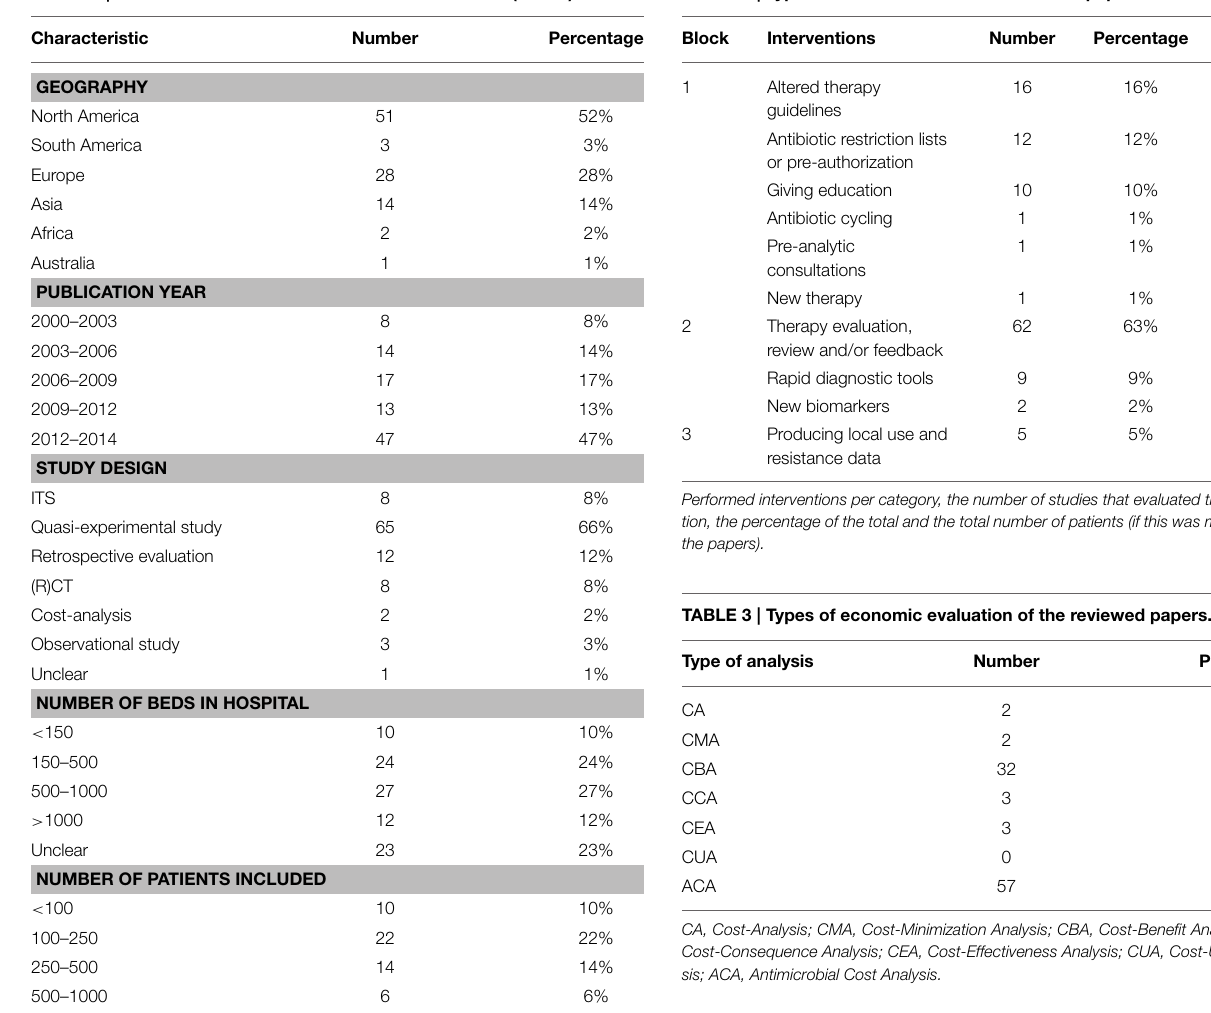
TABLE 1 | General characteristics of the reviewed studies ( n = 99 ). TABLE 2 | Types of interventions of the reviewed papers.